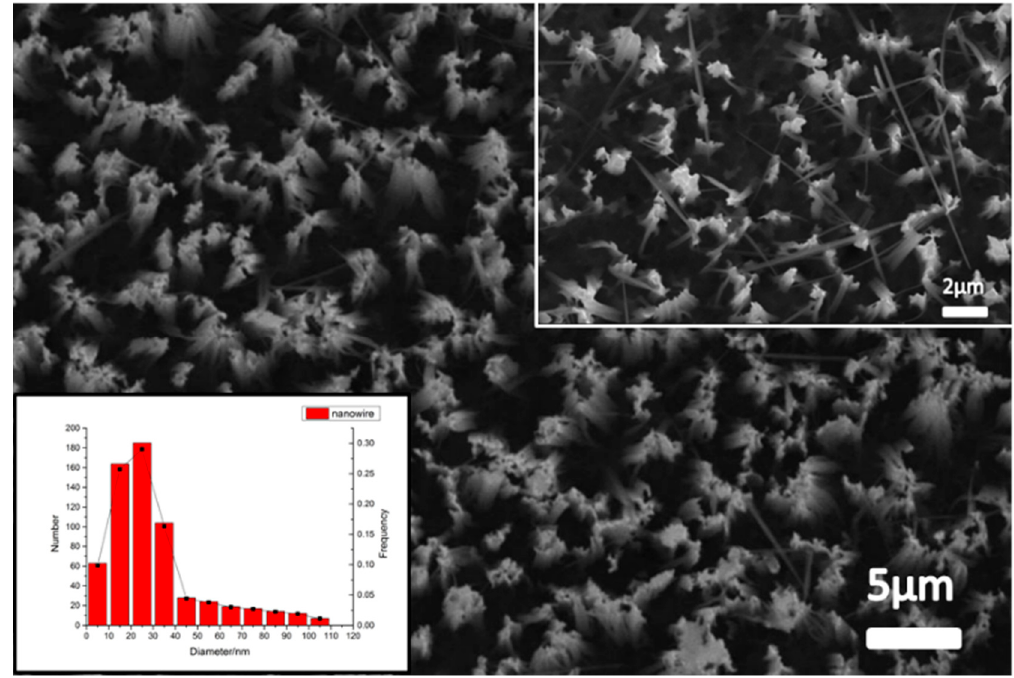
Figure 5. The nanostructures SEM image and frequency, and the number distribution histogram of the nanostructures.